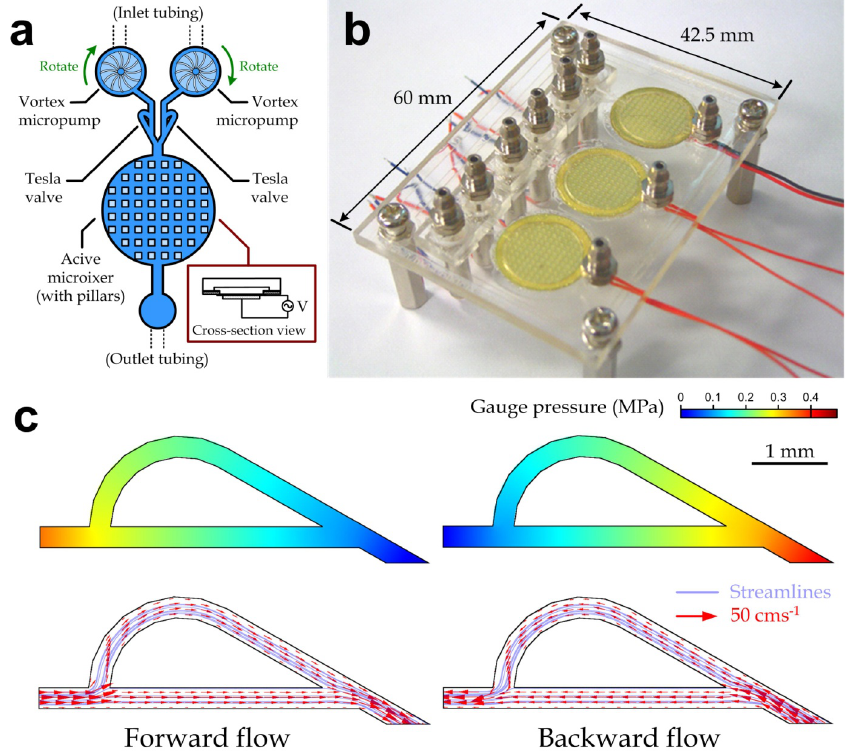
Figure 2. Array of digitally controllable microfluidic mixing modules. ( a ) Device layout of a microfluidic mixing module; ( b ) Photograph of a fabricated device composed of three mixing modules; ( c ) Simulated pressure ( top row) and velocity ( bottom row) profiles of a Tesla valve model for the forward ( left ) and backward ( right ) flow